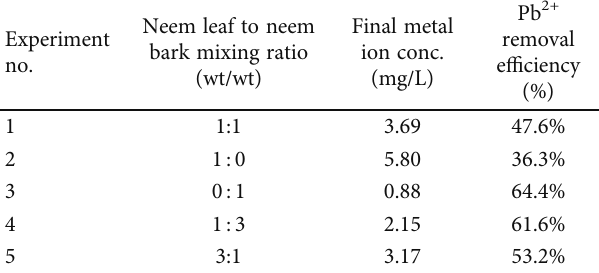
Table 3: Result of mixing of neem leaf and neem bark (at constant parameters in a batch bioadsorption: initialPb 2+ ion conc : = 100 mg/L , pH = 5 , contacttime = 40 min , and bioadsorbent dosage = 0 : 5g/L with mixing time of 5min).